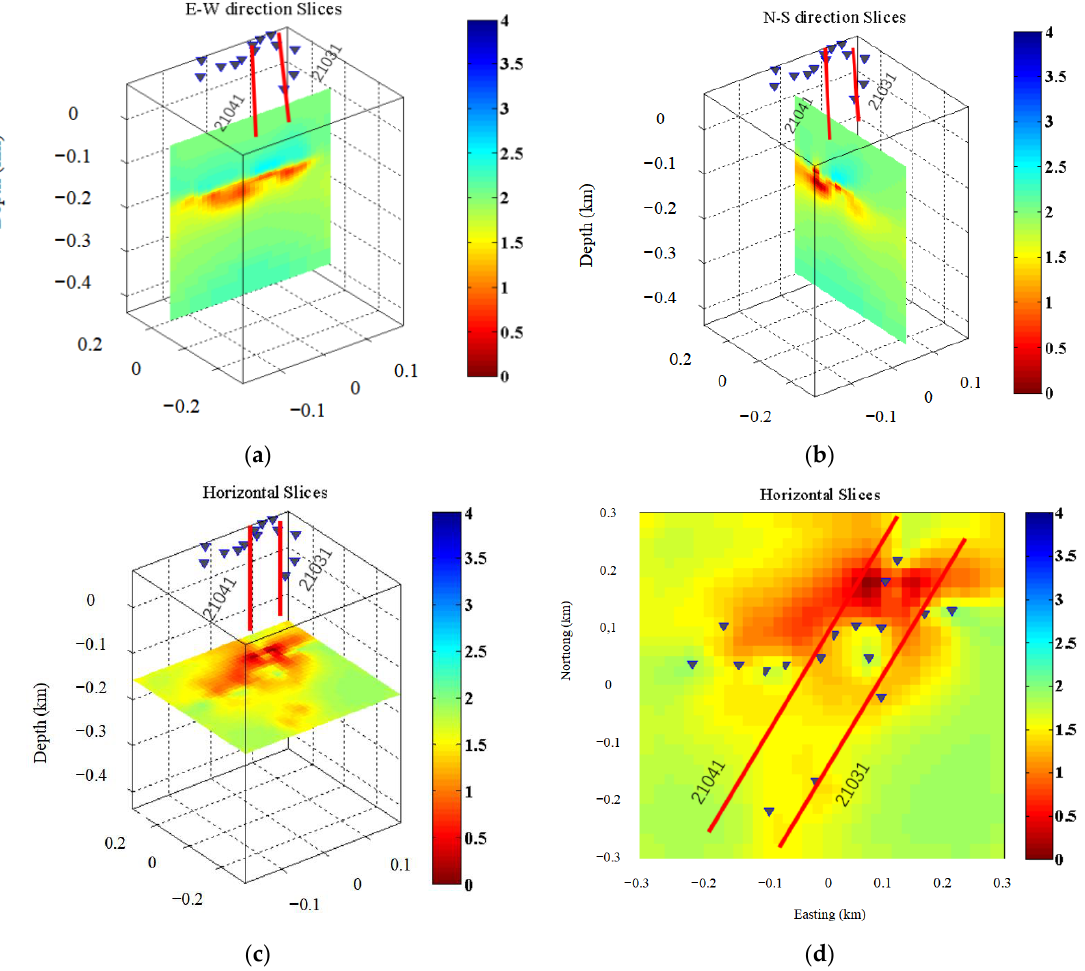
Figure 10. 3D inversion results of the No. 01 coal mining area. ( a ) Slices in the EW direction; ( b ) slices in the NS direction; ( c ) horizontal direction slice at the depths from 310 m to 320 m; ( d ) the horizontal view of the slice in ( c ). The resistivity data is lg ( Ω·m ) .